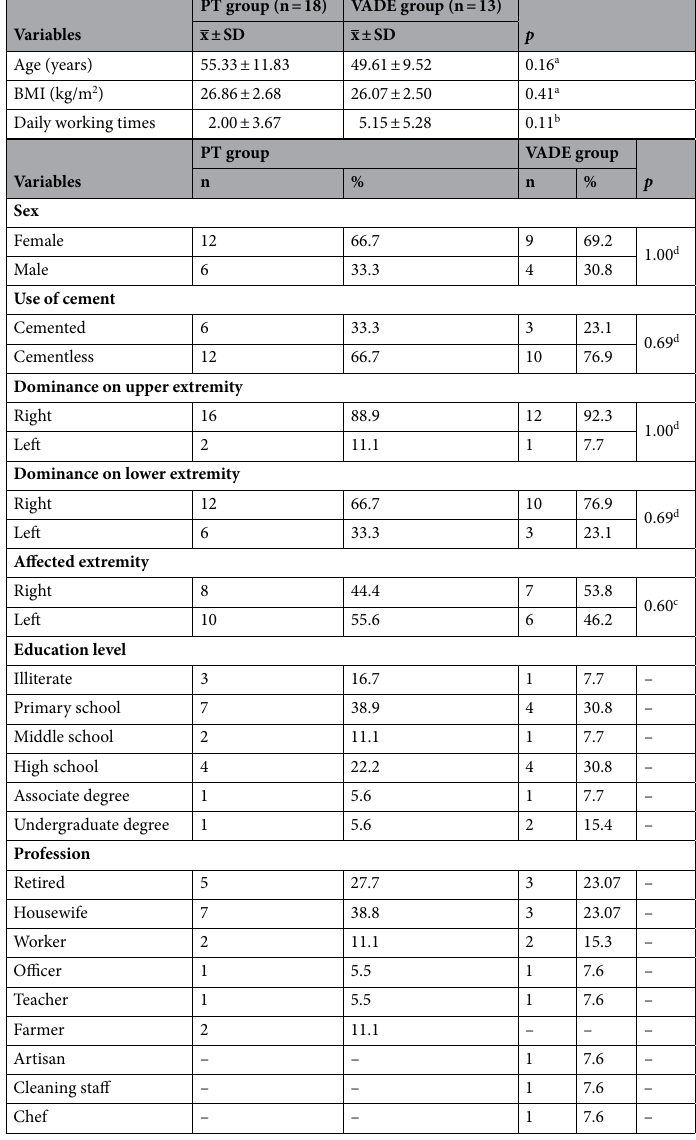
Table 1. Demographic data of patients. PT physiotherapy, VADE video-assisted discharge education, BMI body mass index, kg kilogram, m meter, p < 0.05 statistically significant difference, n sample size, x mean,